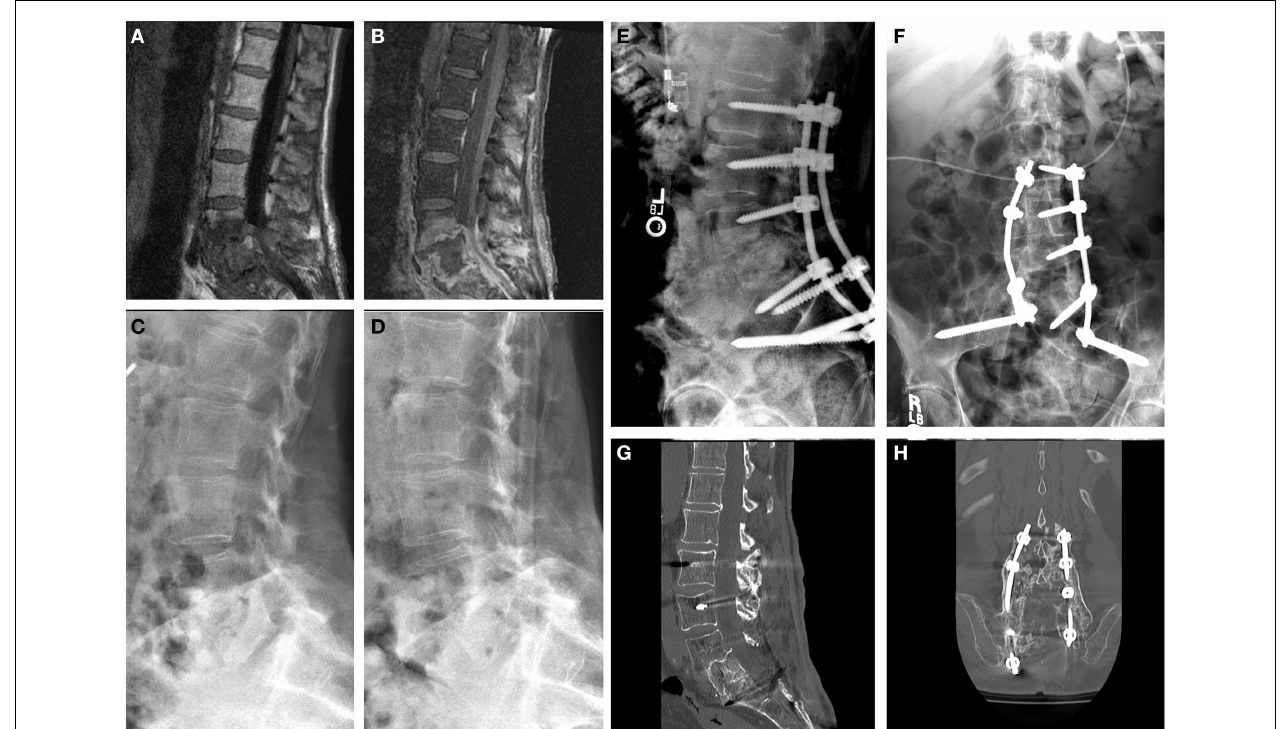
FIGURE 1 | Patient 1 . A 67-year-old woman with severe back pain presented after medical treatment of a polymicrobial sacral decubitus ulcer. Sagittal T1-weighted magnetic resonance images of the lumbar spine with (A) and without (B) contrast demonstrated PVDO at L4–L5–S1 with involvement of the vertebral bodies and endplates. L4–L5 spondylodiscitis with anterolisthesis was present as well as epidural and prevertebral abscesses. Preoperative upright radiographs before (C) and 1month after (D) antibiotic therapy demonstrate progression from Grade I to Grade II L4–L5 anterolisthesis. Posterior-only decompression and fusion without formal debridement of the infected tissues was performed with pedicle screws at L2, L3, right L4, and S1 combined with S2AI screws (E,F) ; poor bone quality precluded instrumentation at L4 on the left and at L5. At 2years, sagittal (G) and coronal (H) CT reconstructions demonstrate stable fusion at the lumbosacral junction.